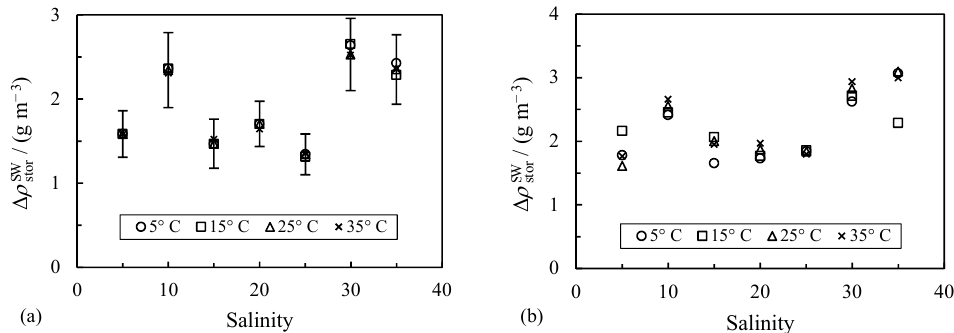
Figure 3. Seawater density increase (cid:49)ρ SW stor caused by dissolution of glass material during storage. Some calculated values of samples used for density measurements (a) at atmospheric pressure and (b) at high pressures. Uncertainty bars in (a) are examples that indicate some uncertainties assigned to values at 25 ◦ C.